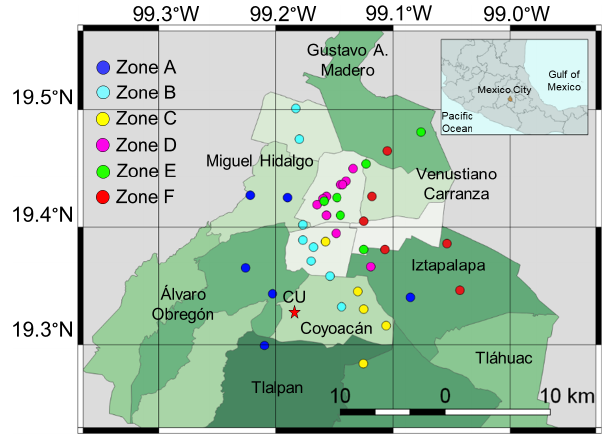
Figure 5. Locations of seismic recording stations in Mexico City (see Table